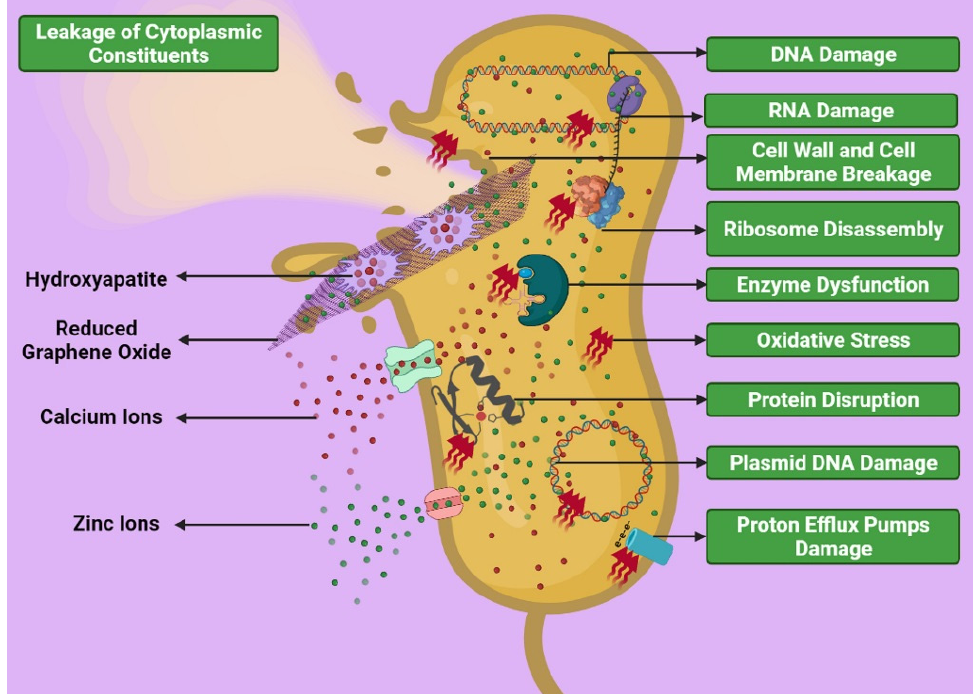
Figure 10. The possible interaction of the ZnHA-rGO nanosystem in the face of bacteria. The three components of the nanocomposite (HA, Zn 2+ , and rGO) damage the cell wall and intracellular components of bacteria.